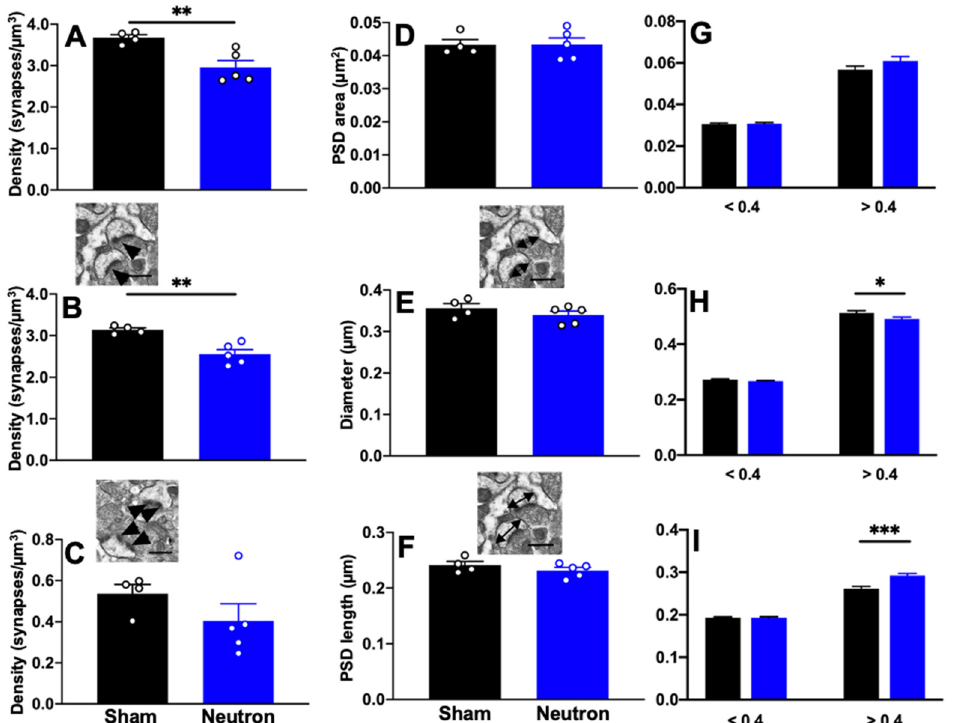
Figure 4. Synapse density is decreased in response to chronic low dose neutron-irradiation. There is a significant decrease in ( A ) total and ( B ) nonperforated synapse density in response to neutron irradiation. ( C ) No significant differences were observed in the density of perforated synapses. ( D ) Quantification of synapse morphology for all synapses revealed no differences in PSD area, PSD length or spine head diameter. However, when we looked at only nonperforated synapses and separated them according to head diameters into small (thin) and large (mushroom) spines, the lack of difference was still present in the PSD area ( G ) we found a significant decrease in larger non-perforated synapses in irradiated mice ( H ) but an increase in PSD length in irradiated mice compared to Sham ( I ). Inset images depict nonperforated and perforated synapses (arrowheads) in ( B , C ), respectively. Insets in ( E , F ) depict PSD and head diameter measurements. Unpaired t-test * p < 0.01, ** p < 0.001, *** p < 0.0001. n = 4 Sham and n = 5 Neutron mice/group. Data represents mean ± SEM.